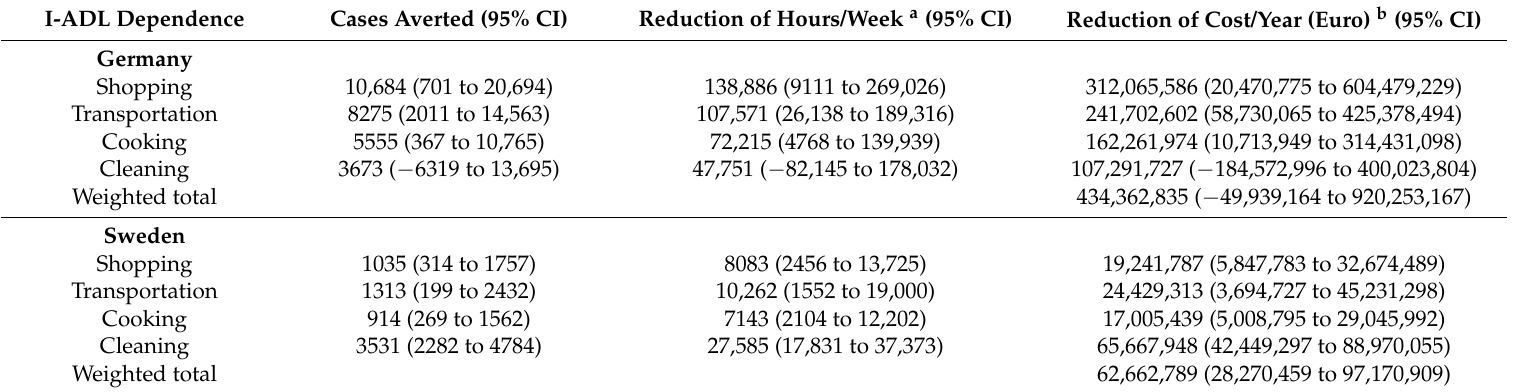
Table 4. Step 5: estimated savings from the reduction of costs for home